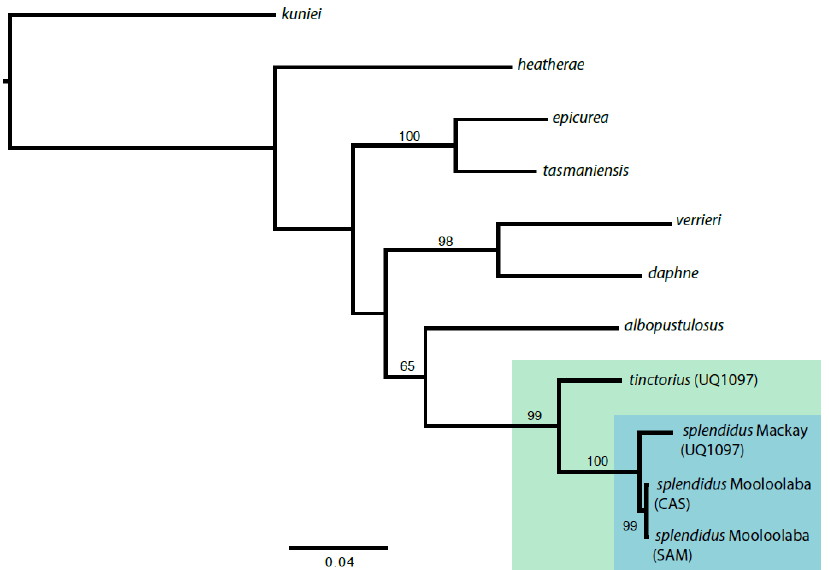
Figure 2. Maximum-likelihood topology for Cytochrome Oxidase I gene (COI) + 16S DNA from selected species of Goniobranchus nudibranchs. Specimens of G. splendidus shown in blue box, and sister species G. tinctorius shown in green box. Bootstrap values less than 60 are not shown.